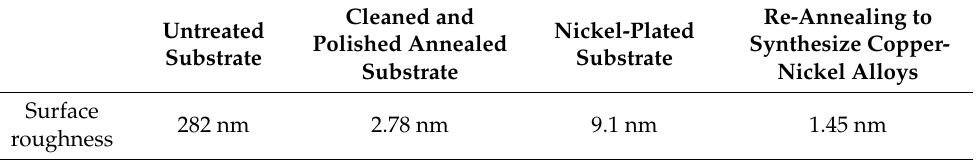
Table 1. The surface roughness of substrates under different